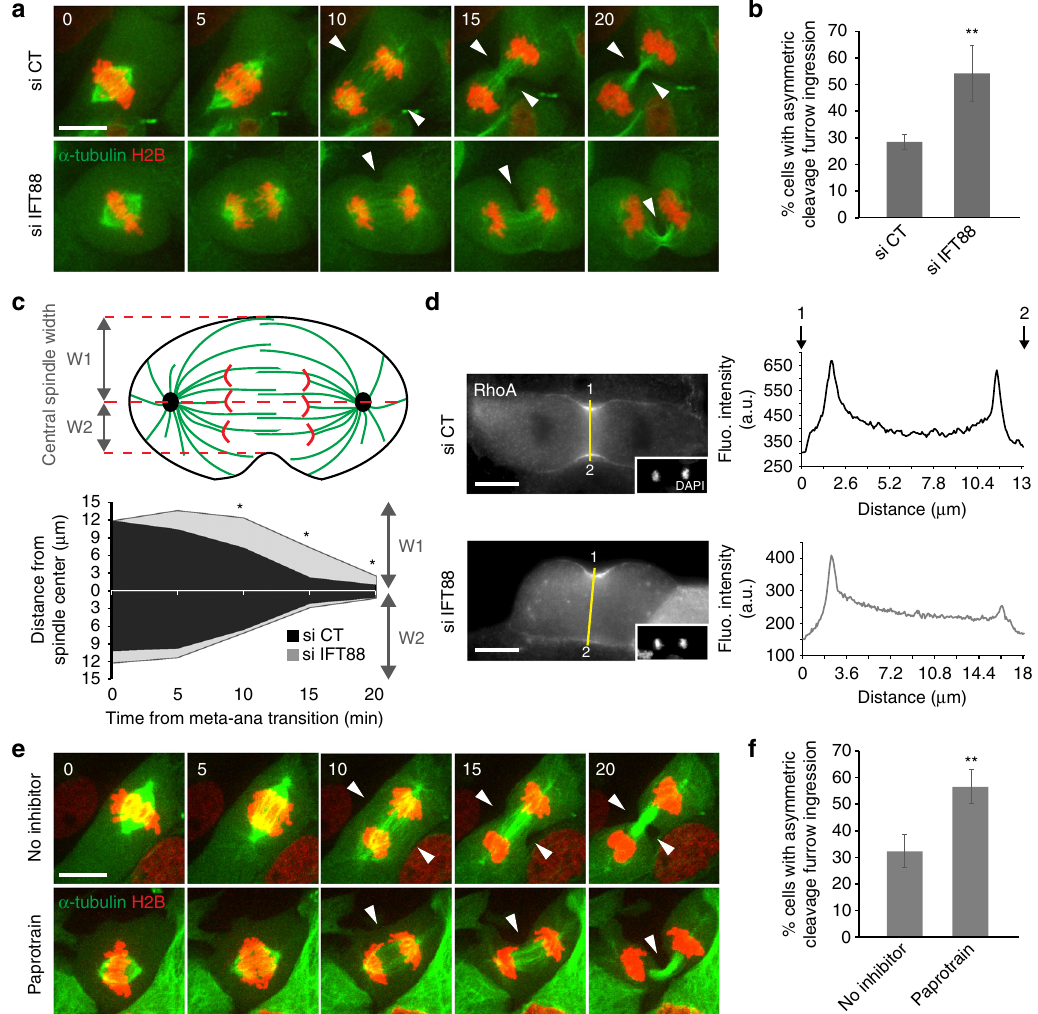
Fig. 4 IFT88 is required for symmetrical cleavage furrow ingression in kidney cells. a Images from time-lapse microscopy showing cytokinesis progression of LLC-PK1 cells stably expressing GFP- α -tubulin and mCherry-H2B. White arrowheads indicate the position of cleavage furrow ingression. Time (min). b Percentage of cells undergoing asymmetric cleavage furrow ingression as shown in 4a. n > 31 cells. Three experiments. Mean+ / − s.d. ** P < 0.01 compared to control ( t test). c Schematics of an anaphase cell exhibiting asymmetric cleavage furrow ingression (upper panel) as observed in IFT88- depleted cells. Grey arrows de fi ne the central spindle width (W1, larger side where the ingression is delayed; W2 shorter side where the ingression occurs properly). Quanti fi cation of cleavage furrow ingression asymmetry over time (bottom graph). W1 and W2 distances are measured from the center of the central spindle during the metaphase to anaphase transition in control (black) or IFT88-depleted cells (grey). n = 8 cells. For W1 * P < 0.05 compared to control ( t test). d Immuno fl uorescence images showing RhoA localization in anaphase LLC-PK1 cells transfected with control or IFT88 siRNA. DAPI (inset). Line scans (right), RhoA fl uorescence intensity along the yellow line measured from 1 to 2. e Images from time-lapse microscopy showing cytokinesis progression of LLC-PK1 cells (GFP- α tubulin/mCherry-H2B) treated or not with MKLP2 inhibitor (Paprotrain). White arrowheads indicate the position of cleavage furrow ingression. Time (min). f Quanti fi cation of the percentage of cells undergoing asymmetric cleavage furrow ingression. n > 32 cells. Three experiments. Mean+ / − s.d. ** P < 0.01 compared to control ( t test). Scale bars: 10 μ m times (200 µ l) and resuspended in Laemmli buffer. Pulled-down proteins were detected by Coomassie blue staining and western blot. Yeast two-hybrid experiments . Yeast two-hybrid experiments were performed by co-transforming the Saccharomyces cerevisiae reporter strain L40 with either pGAD-IFT88 or pGAD alone together with either pLex-mMKLP2 N-term (aa 1- 529), pLex-mMKLP2 C-term (aa 530-887), pLex-mMKLP2 M1-Q665 (aa 1-665) or pLex alone. Transformed yeast colonies were selected on DOB agarose plates without Tryptophane and Leucine. Colonies were picked and grown for 3 days on DOB agar plates with Histidine to select co-transformants and without Histidine to detect interactions. Antibodies . The following primary antibodies were used (western blot WB, immuno fl uorescence IF): IFT88 #13967-1-AP (WB: 1/500, IF: 1/250), IFT52 NATURE COMMUNICATIONS | 8: